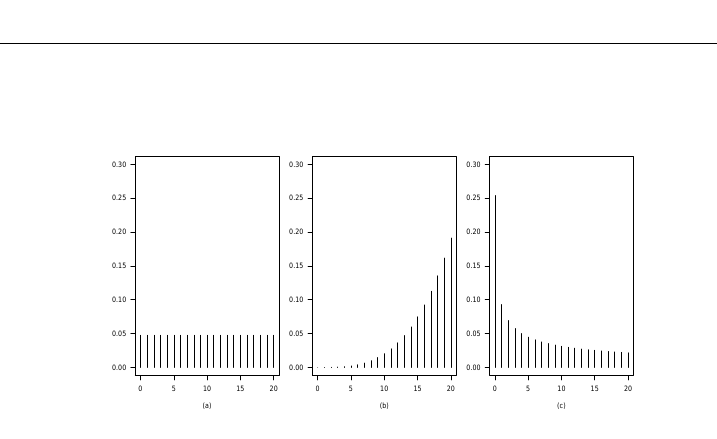
} , in panel (a), where m − 1 = 20, and power Figure 1 – An original uniform distribution { p i ( α ) } , for m − 1 = 20 and α = 4.35, in panel (b), and for m − 1 = 20 and uniform distributions { r i α = 0.45, in panel (c).